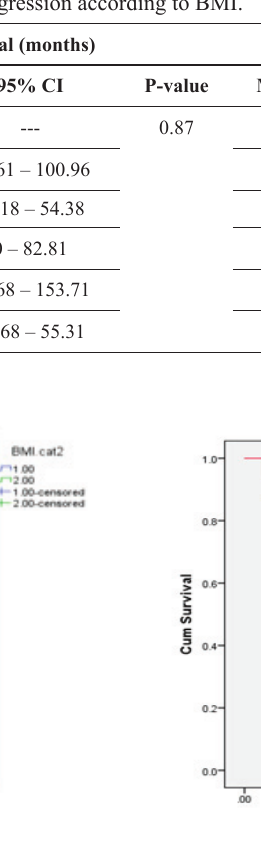
Figure. 3: Kaplan Meier curves showing overall survival